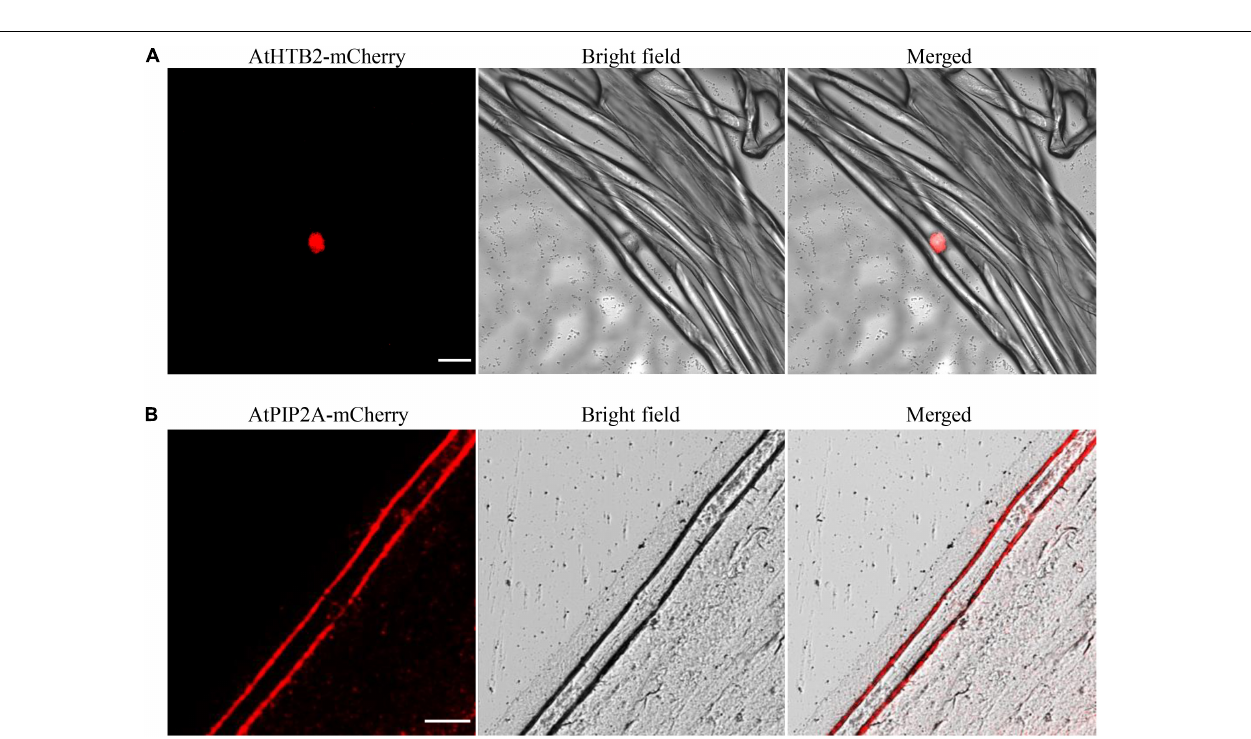
FIGURE 6 | Subcellular localization of mCherry-tagged proteins in fiber cells. (A) A strong fluorescence signal was observed in the nucleus of fiber cells transformed with Agrobacterium harboring 35S:: AtHTB2 -mCherry construct. (B) A strong fluorescence signal was observed in the plasma membrane of fiber cells transformed with Agrobacterium harboring 35S:: AtPIP2A -mCherry construct. White lines indicate 50 µ m. AtHTB2, Arabidopsis thaliana histone B2; AtPIP2A, an aquaporin, short for Arabidopsis thaliana plasma membrane intrinsic protein. Fibers at 20 DPA were used for transformation.